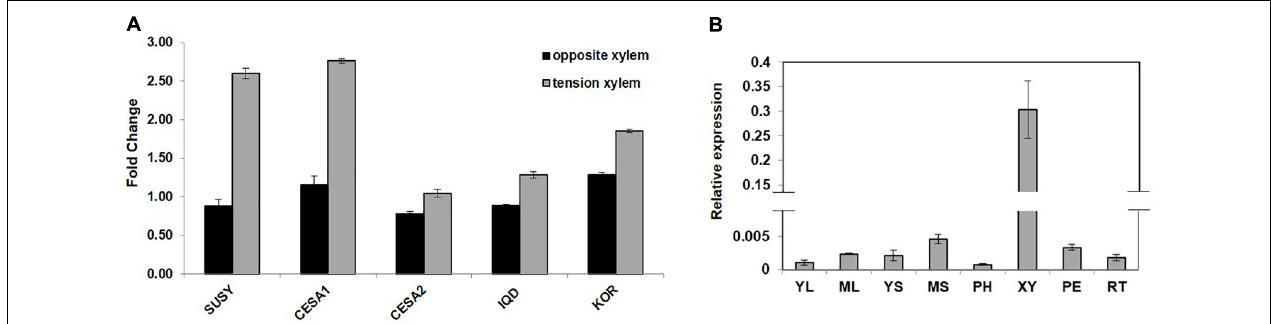
FIGURE 1 | (A) Expression profile of cell wall related genes in tension stressed and opposite xylem tissue. qRT-PCR data showing the relative transcript levels of the chosen genes involved in cell-wall formation. Known cellulose pathway marker genes such as sucrose synthase ( SUSY; Potri.006G136700 ) cellulose synthases ( CESA1; Potri.004G059600, PdCESA8-B; CESA2; Potri.018G103900, PdCesA7-B) , and KOR (Potri.001G078900) display higher expression in the tension stressed xylem tissue along with IQD ( PdIQD10 ; Potri.001G375700) gene as compared to the opposite xylem. (B) Transcript profiling of PdIQD10 in various tissues of Populus . The expression levels of PdIQD10 was determined by qRT-PCR method using Populus cDNA libraries of Young Leaf (YL), Mature Leaf (ML), Young Stem (YS), Mature Stem (MS), Phloem (PH), Xylem (XY), Petiole (PE) and Root (RT). As shown in the figure, the expression of PdIQD10 transcript is highest in xylem tissue followed by mature stem. Standard deviation was calculated across biological replicate libraries ( n = 3). A break in Y -axis denotes discontinuity in scale. The corresponding figure with continuous Y-axis scale is provided as Supplementary Figure S9 . Relative expression was based on changes in critical threshold (R C RT) values relative to housekeeping